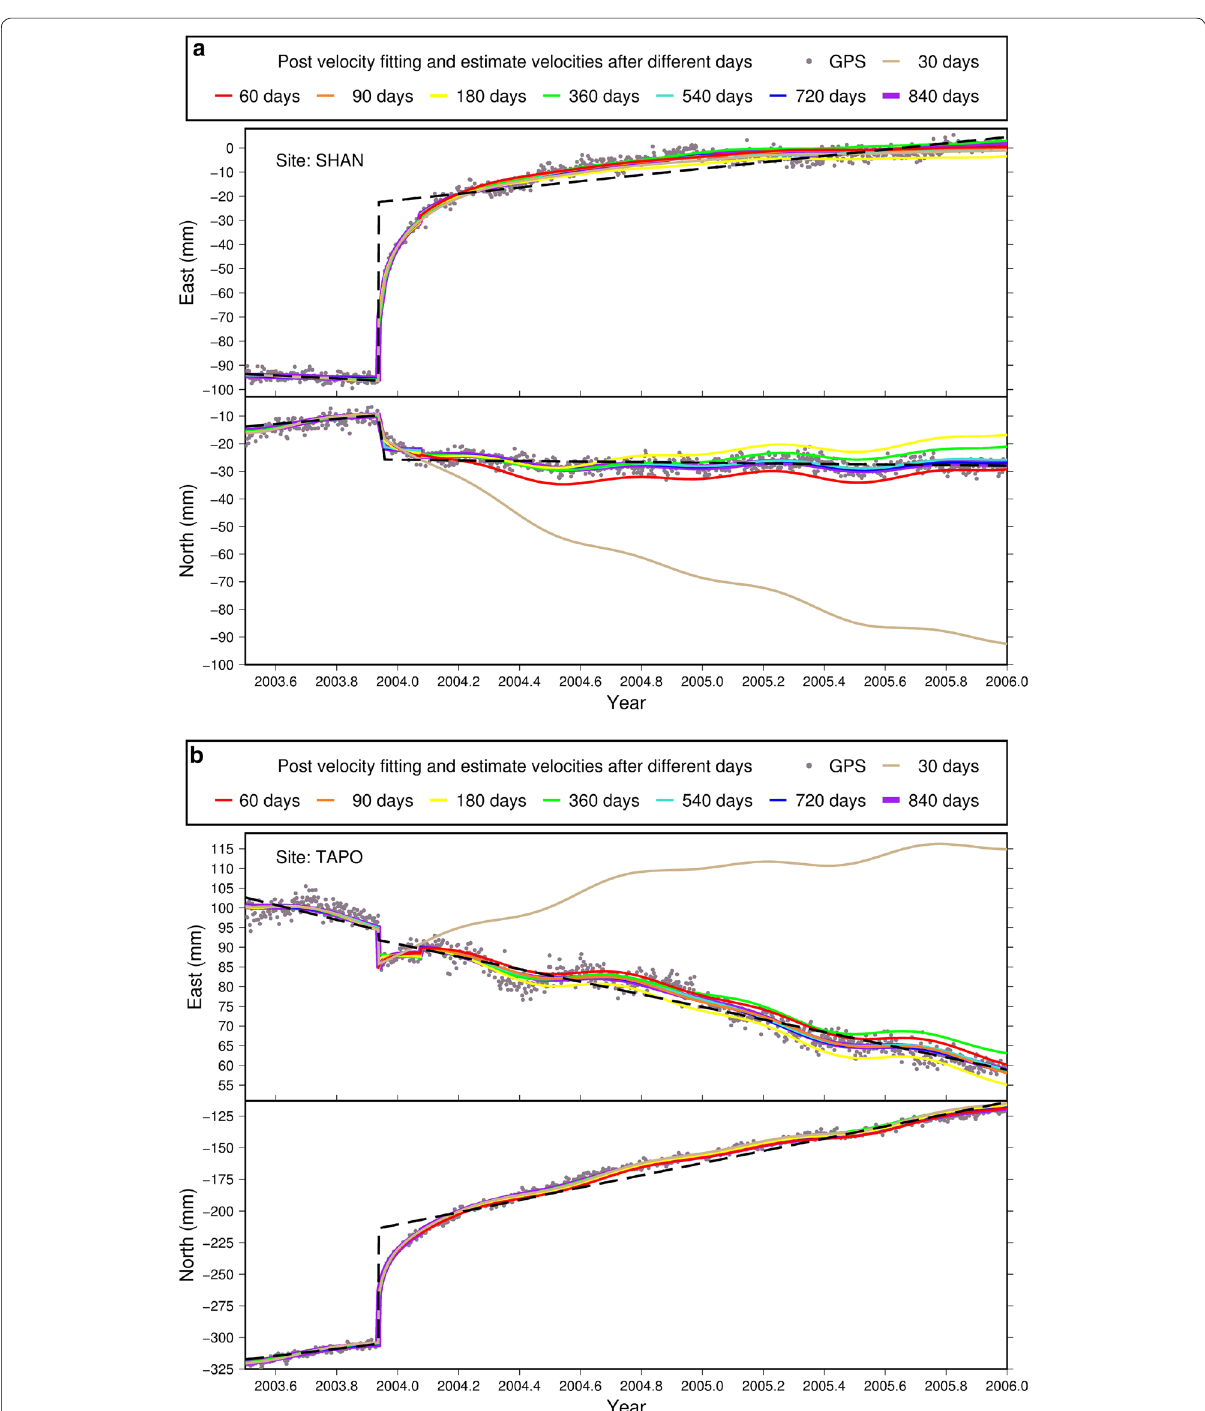
Fig. 2 Examples of GPS time series fitting for postseismic deformation at stations a SHAN and b TAPO. The time series were fitted with Eq. (1). All the time series have preseismic data for 2 years, but we only show preseismic data for half a year to focus on the postseismic fitting. Different color lines represent fitting curves derived from 30, 60, 90, 180, 360, 540, 720 and 840 days of data. Dash line is fitted by different linear velocities before and after the earthquake following the method of Li et al.